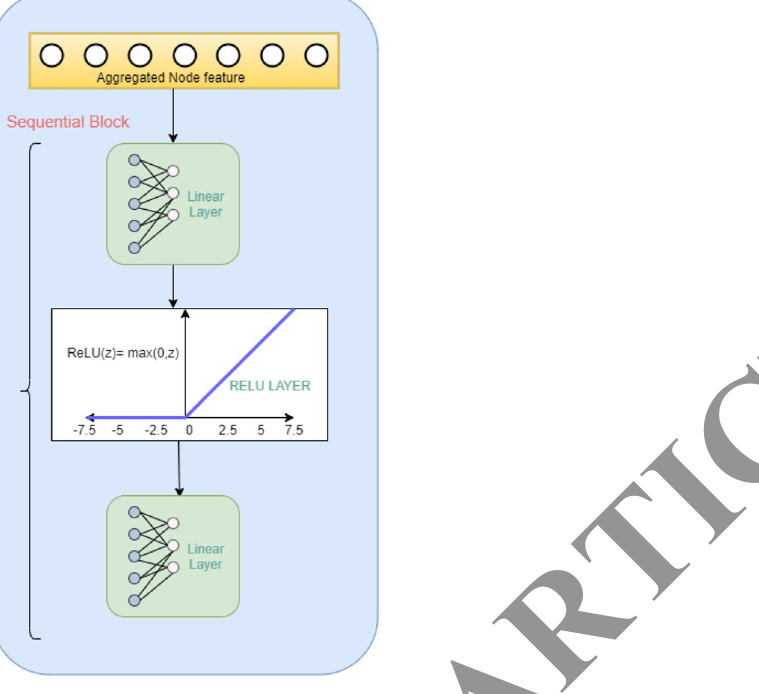
Figure 10. Diagram representing the MLP architecture of GINConv Layer.